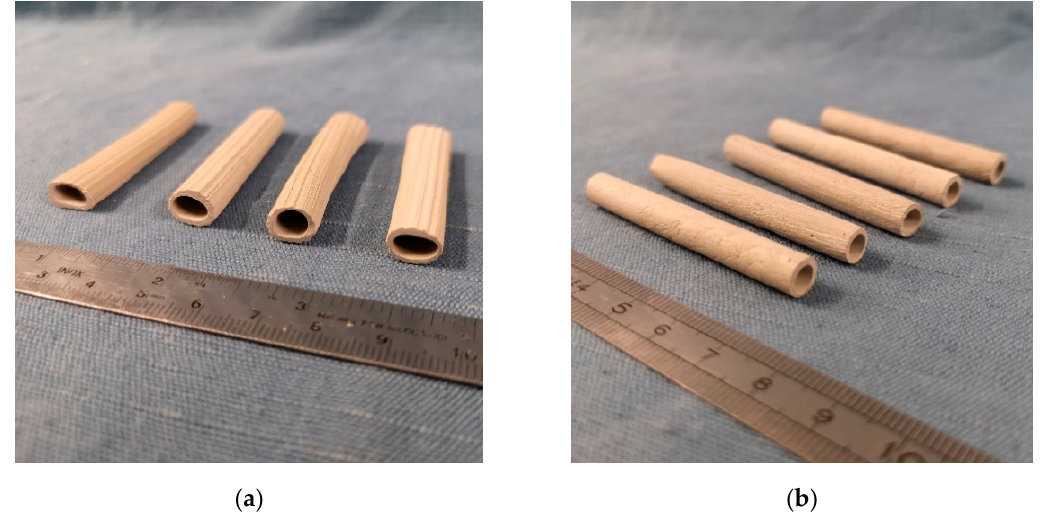
Figure 1. Cementitious tubular capsules produced by extrusion ( a ) and by rolling ( b